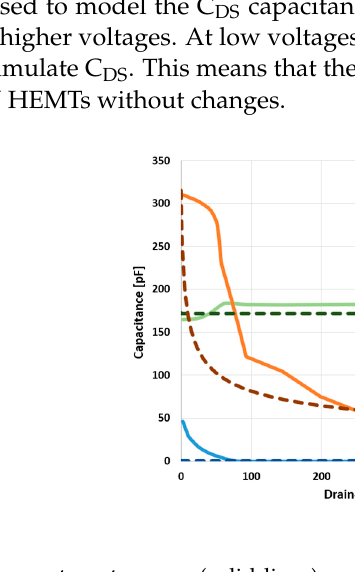
Figure 15. Comparison between target curves (solid lines) and simulated curves (dashed lines): ( a ) capacitance characteristic of GS66504B; ( b ) capacitance characteristic of GS66504B. Additionally, in [61], the capacitance behaviours of a GaN HEMT have been emulated through the MOSFET LEVEL 1. However, the MOSFET LEVEL 1 model does not present a satisfactory result for modelling GaN